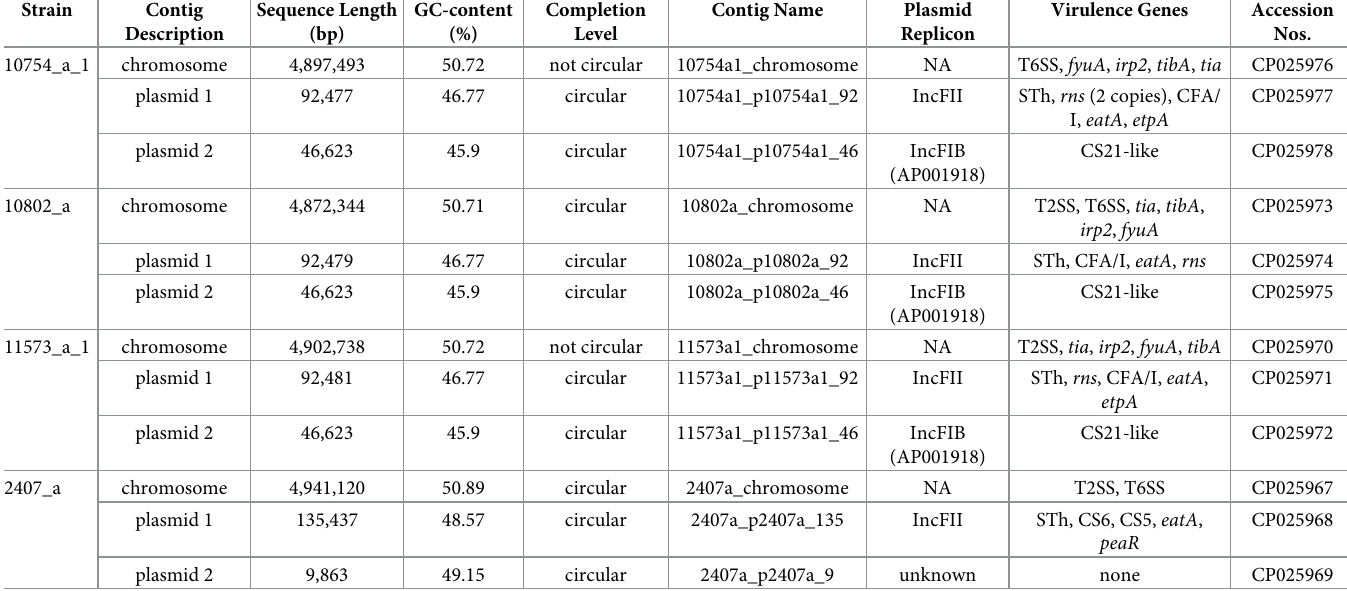
Table 1. In silico determined characteristics of the ETEC genomes selected for complete genome